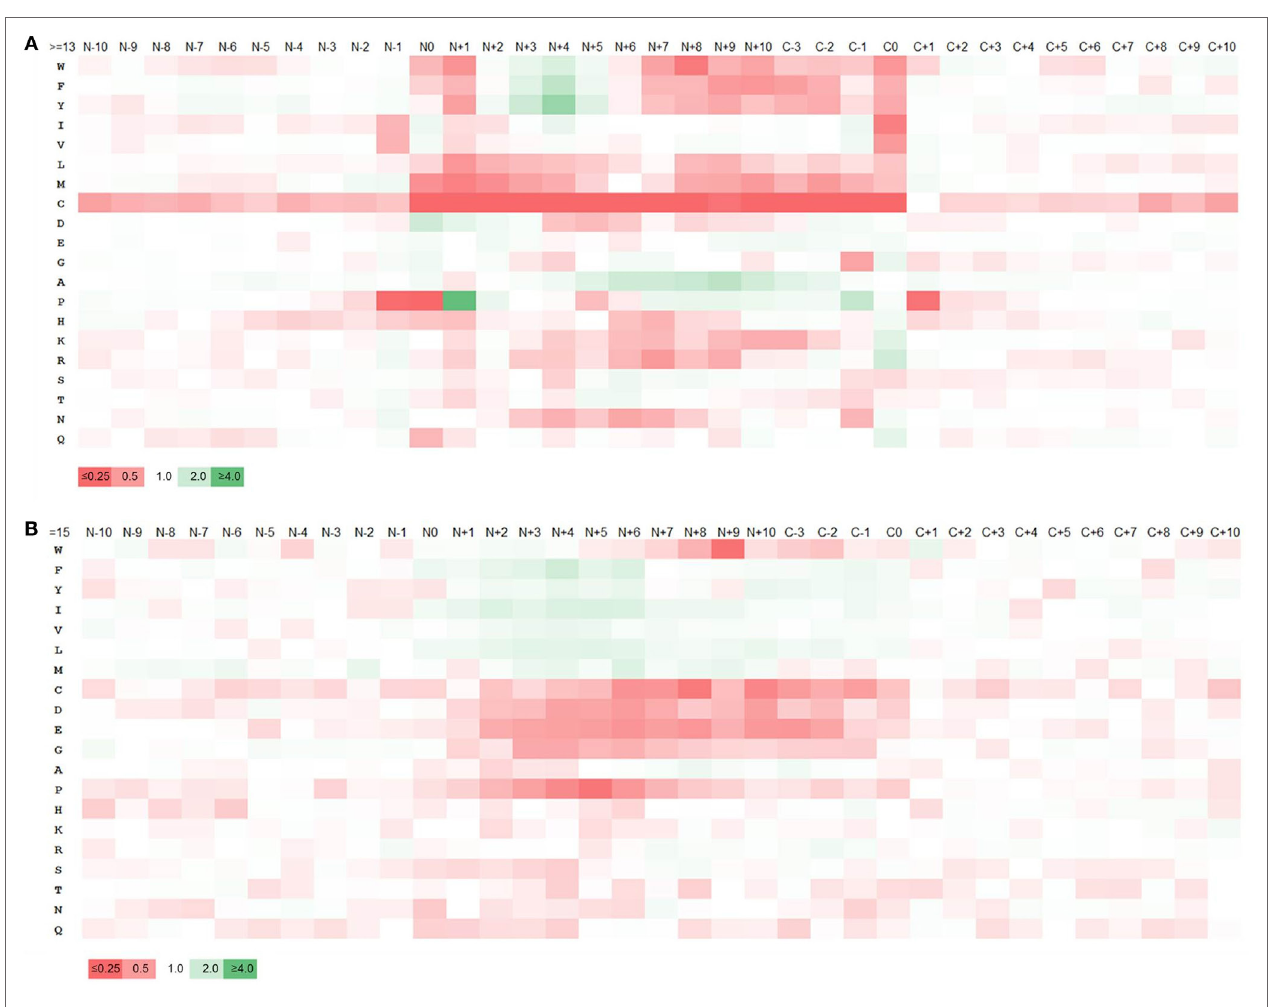
FigUre 2 | Enrichment and depletion of amino acids within and adjacent to major histocompatibility complex (MHC) II ligands and predicted MHC II binders. Heatmaps generated from the relative frequencies of amino acids at ligands/binders and nearby positions with respect to the overall amino acid frequency of the source proteins. “N” and “C” represents the N- and C-terminuses of the ligands, respectively and the numbers represent the amino acid positions with respect to N- and C-terminuses. The legend shows the color scale of the heat map with respect to the relative frequency of amino acids which is represented by the numbers on the legend. (a) Heatmap generated from ligands. (B) Heatmap from predicted binders. The pattern of amino acid enrichment and depletion was found to be significantly different between the heatmaps generated based on cleavage motif and binding